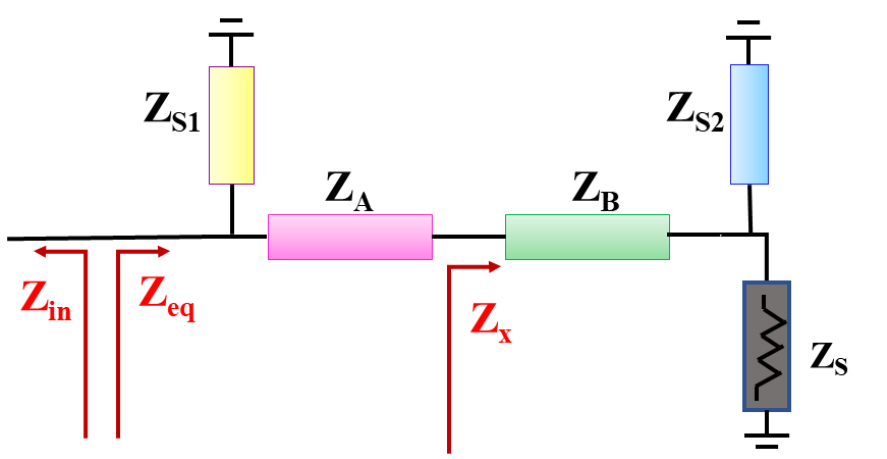
Figure 16. Even-mode analysis of